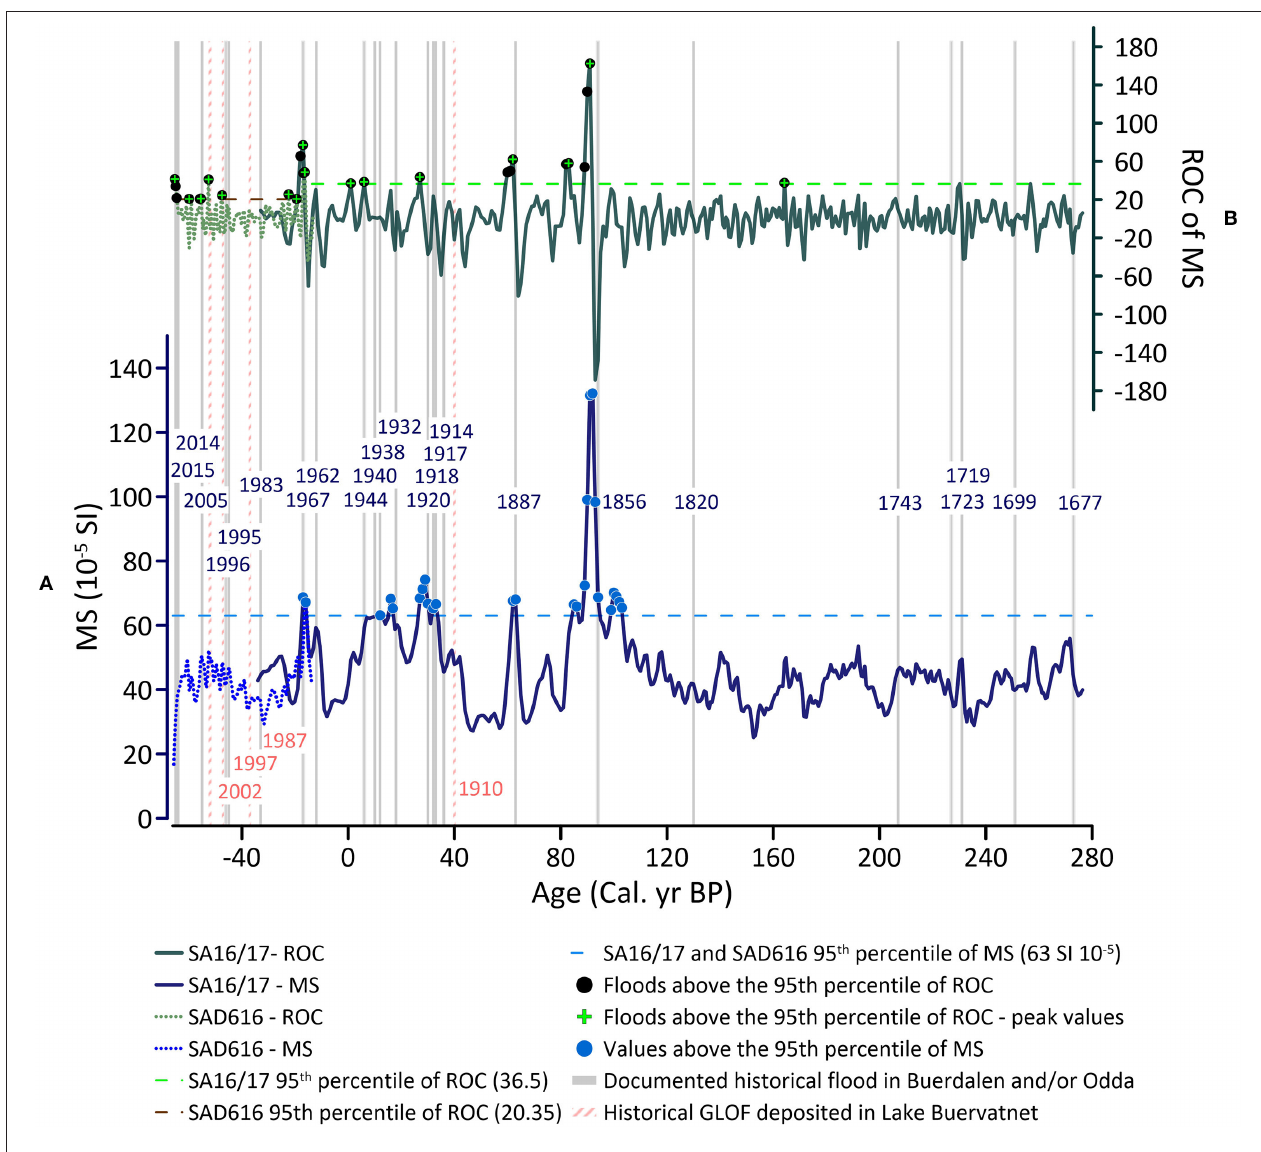
FIGURE 12 | (A) Magnetic susceptibilities (MSs) of both SA16/17 (dark blue line) and SAD616 (bright blue dotted line) correlated using their age from 1963 AD ( − 13 yr BP). (B) Rate of change (ROC) of both SA16/17 (dark green line) and SAD616 (bright green dotted line) correlated using their age from 1963 AD ( − 13 yr BP). Historical documented floods (gray bars) are compared with glacial outburst floods (GLOFs) from Buervatnet (orange striped bars) and MS (blue dots) and ROC (black dots) values above the 95th percentile. The ROC values above the percentile are data points included in the two flood reconstructions with, all (black dots) and peak values only (green crosses; Figure 13 ). The documented floods and GLOFs are presented with the year (AD) that they occurred (Roald, 2013; Kraftmuseet, 2019). The maximum uncertainty range of the ages for the SA16/17 is 107–220 years in the top 280